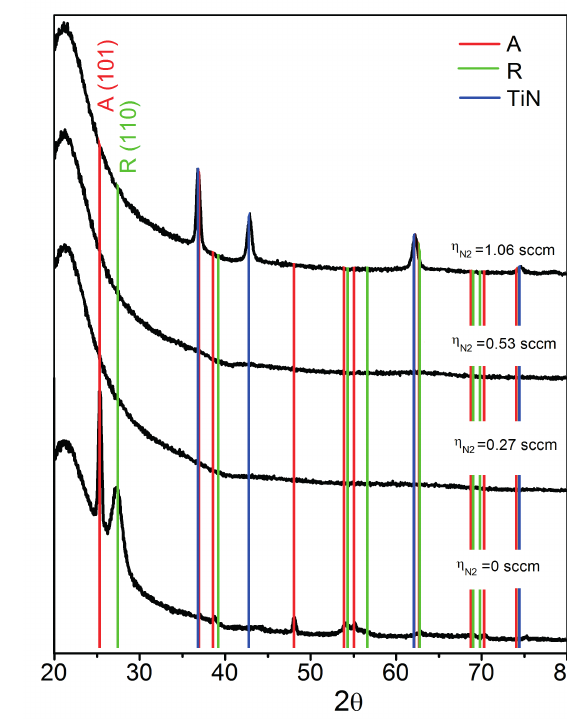
:N thin films deposited onto 2 =0.13 under controlled nitrogen 0